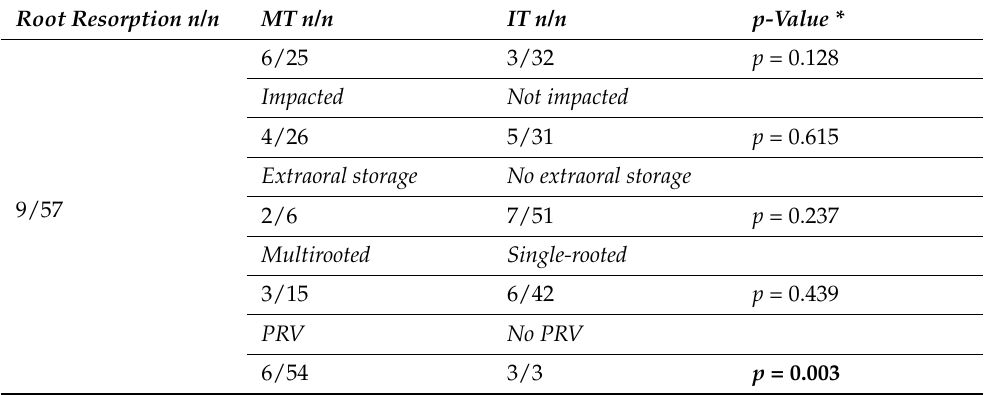
Table 1. Root resorption, part 1.